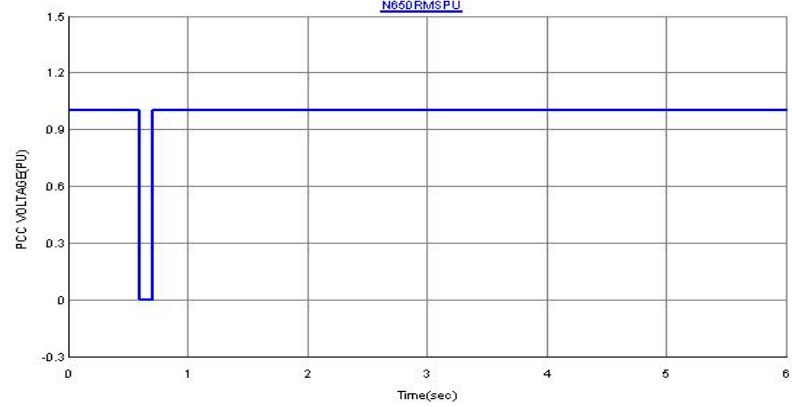
Figure 21. PCC pu voltage during island fault.